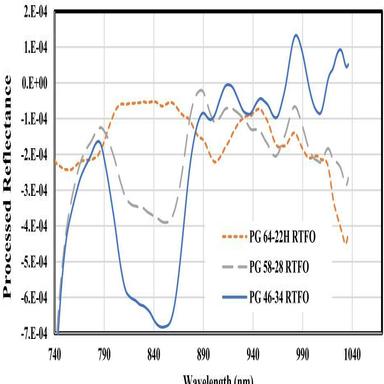
Comparison of different RTFO-aged binders.